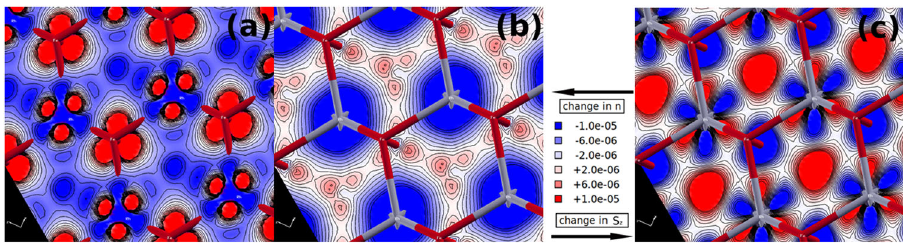
Fig. 5 Computed photoinduced changes in charge and spin density in FeRh. a , b Changes in the charge density n ( r , t f ) − n eq ( r ) and ( c ) spin density S ð r ; t Þ (cid:2) S eq ð r Þ at the end of the laser pulse ( t = t fi guration. Densities are in atomic units ([ e = a 3 ] and [ μ B = a 3 ], where f ) with respect to the equilibrium con z f z 0 0 a = 5.29 × 10 − 11 m is the Bohr radius. 0.25 electron per unit cell corresponds to a density of 7 ´ 10 (cid:2) 4 e = a 3 .) on two different FeRh{111}-planes: the plane 0 0 just below the Fe ( ↑ ) atoms ( a ) and the plane containing the Rh atoms ( b , c ). Fe and Rh atom positions are indicated by red and gray segments of the lattice, respectively. Charge is transferred from the occupied (bonding) orbitals of Rh atoms (panel b ), to the unoccupied (anti-bonding) orbitals of Rh and Fe ( a ). Since the Fe anti-bonding levels are fi lled in this process, the local Fe spin density is reduced. As a result, there is a redistribution of spin density around the Rh atoms and a reduction of the local spin moment at the Fe atoms ( c ). The movies in the Supplementary Information show the simulated time evolution of the charge density variations at the Fe and Rh sites as represented in ( a ) and ( b ) at the beginning and the end of the